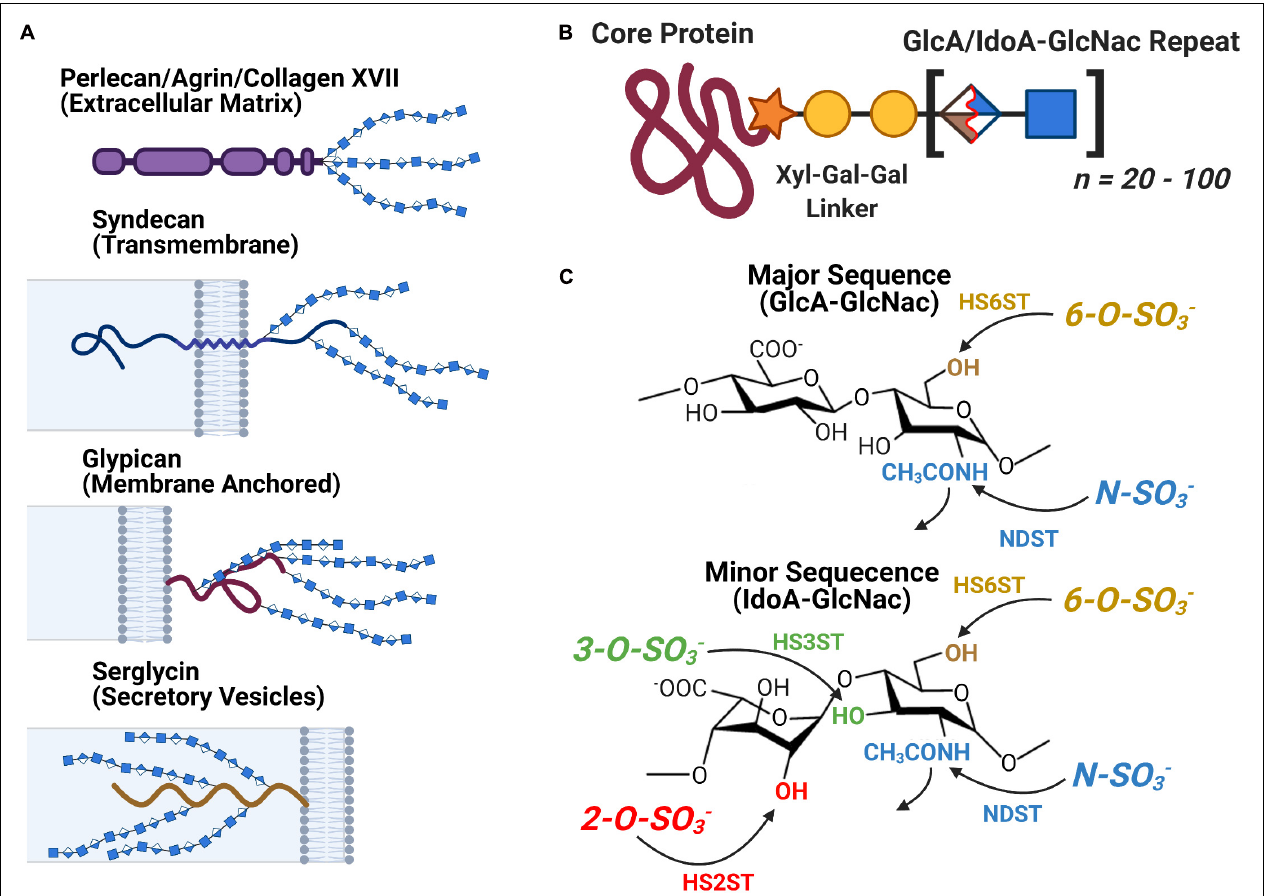
FIGURE 3 | The Structure and Localization of Heparan Sulfate and its Proteoglycans. (A) The different families of HSPG core proteins exhibit a range of distinct localizations. (B) An HSPG consists of a core protein covalently attached to several HS glycan chains, each consisting of between 20 to 100 HS disaccharide units. (C) The chemical structure of the major and minor HS disaccharide repeats. The glycan’s variable sulfation sites are noted along with the name of the corresponding family of